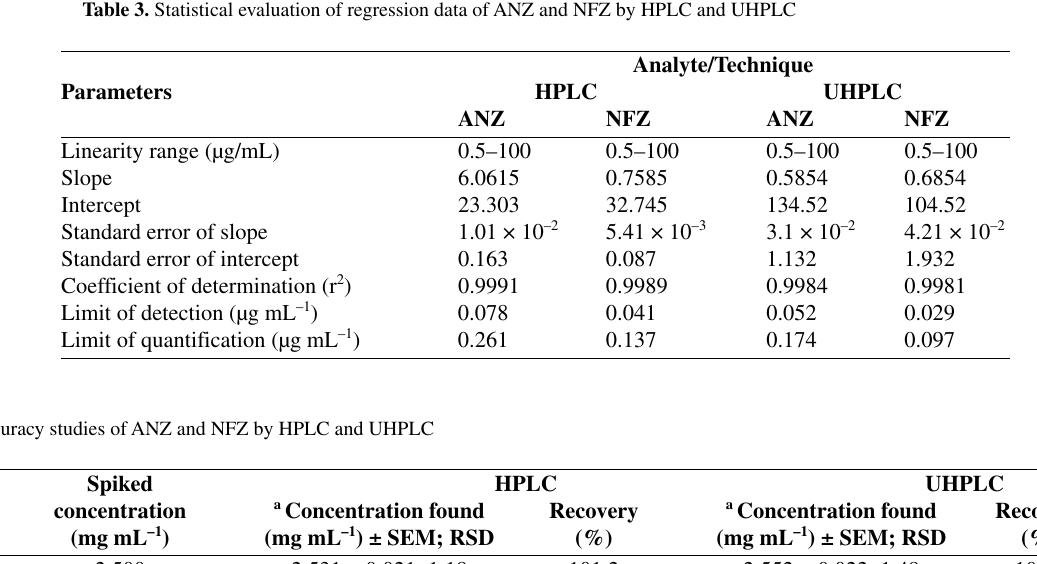
Table 3. Statistical evaluation of regression data of ANZ and NFZ by HPLC and UHPLC